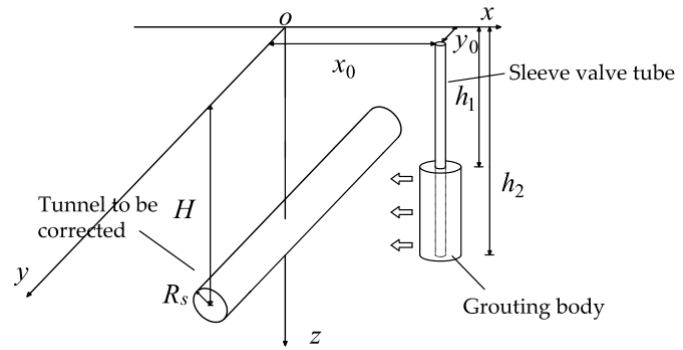
Figure 2. The mechanical calculation model.